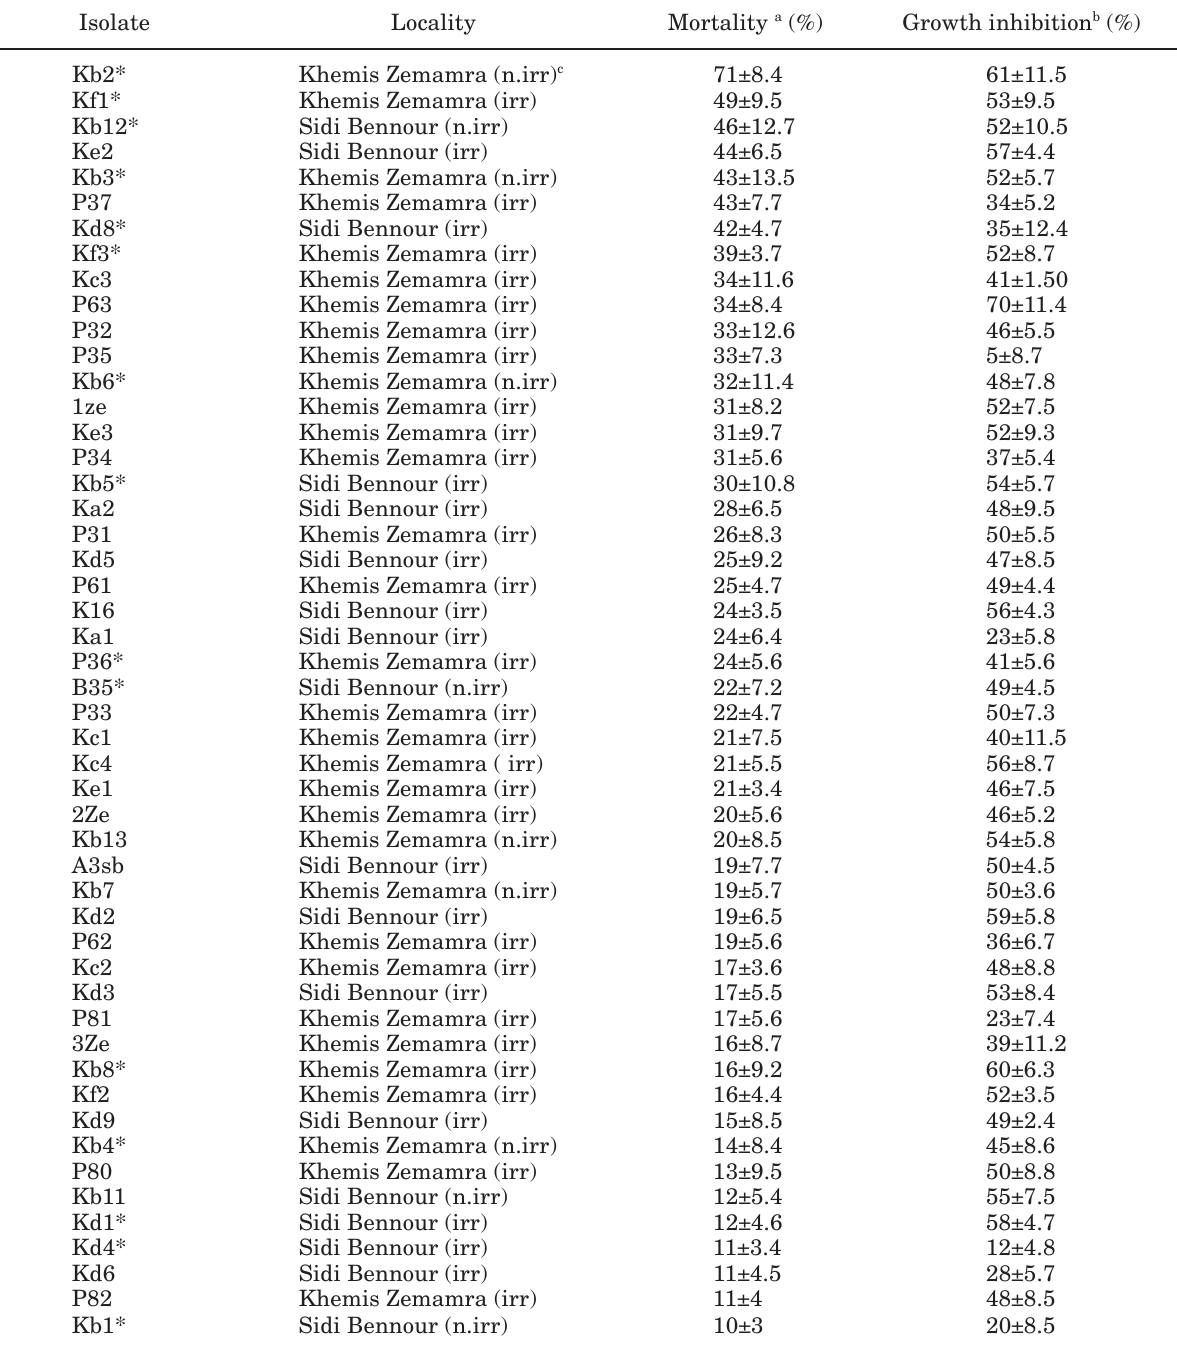
Table 1. Antagonistic action of Trichoderma isolates, originating from Doukkala, on S. rolfsii . Isolate